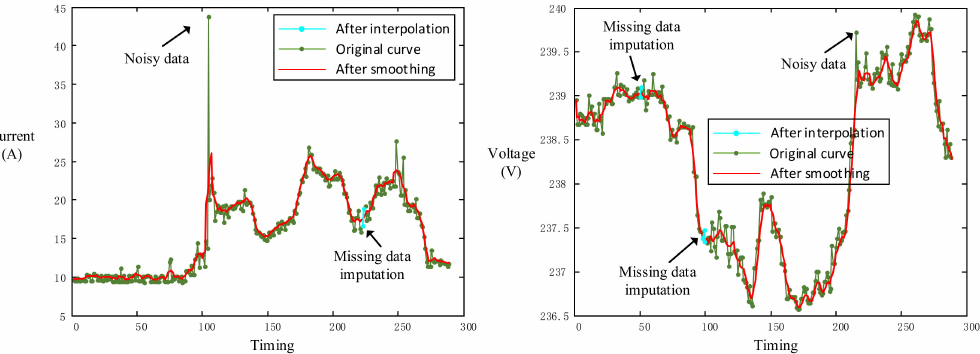
Figure 8. Example diagram of current and voltage curve interpolation and smoothing